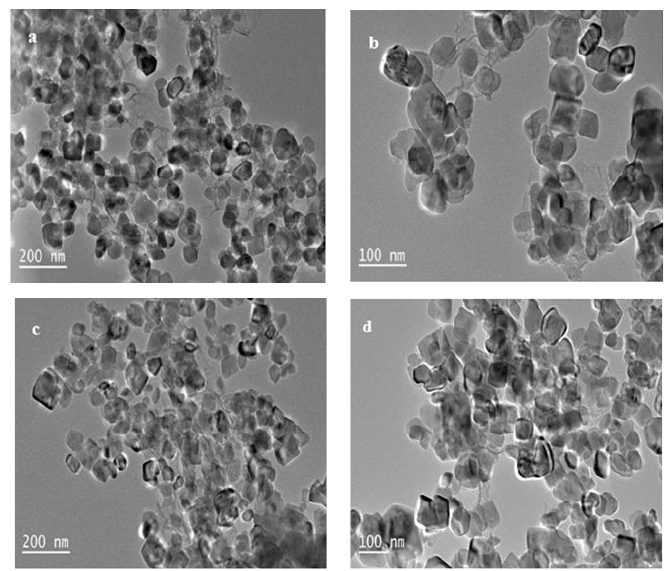
Figure 2. SEM images of TiO 2 -RGO: ( a , b ) TiO 2 -6%RGO, ( c , d ) TiO 2 -12%RGO. Figure 3a,b are the TEM images of TiO 2 -6%RGO. It was observed that the graphene sheets with overlapping wrinkles are interspersed between the TiO 2 particles. The sample particles are relatively uniformly dispersed, and the particle size is relatively consistent. The TiO 2 -12%RGO particles were disorderly stacked and agglomerated together (Figure 3c,d), which is consistent with the SEM results.